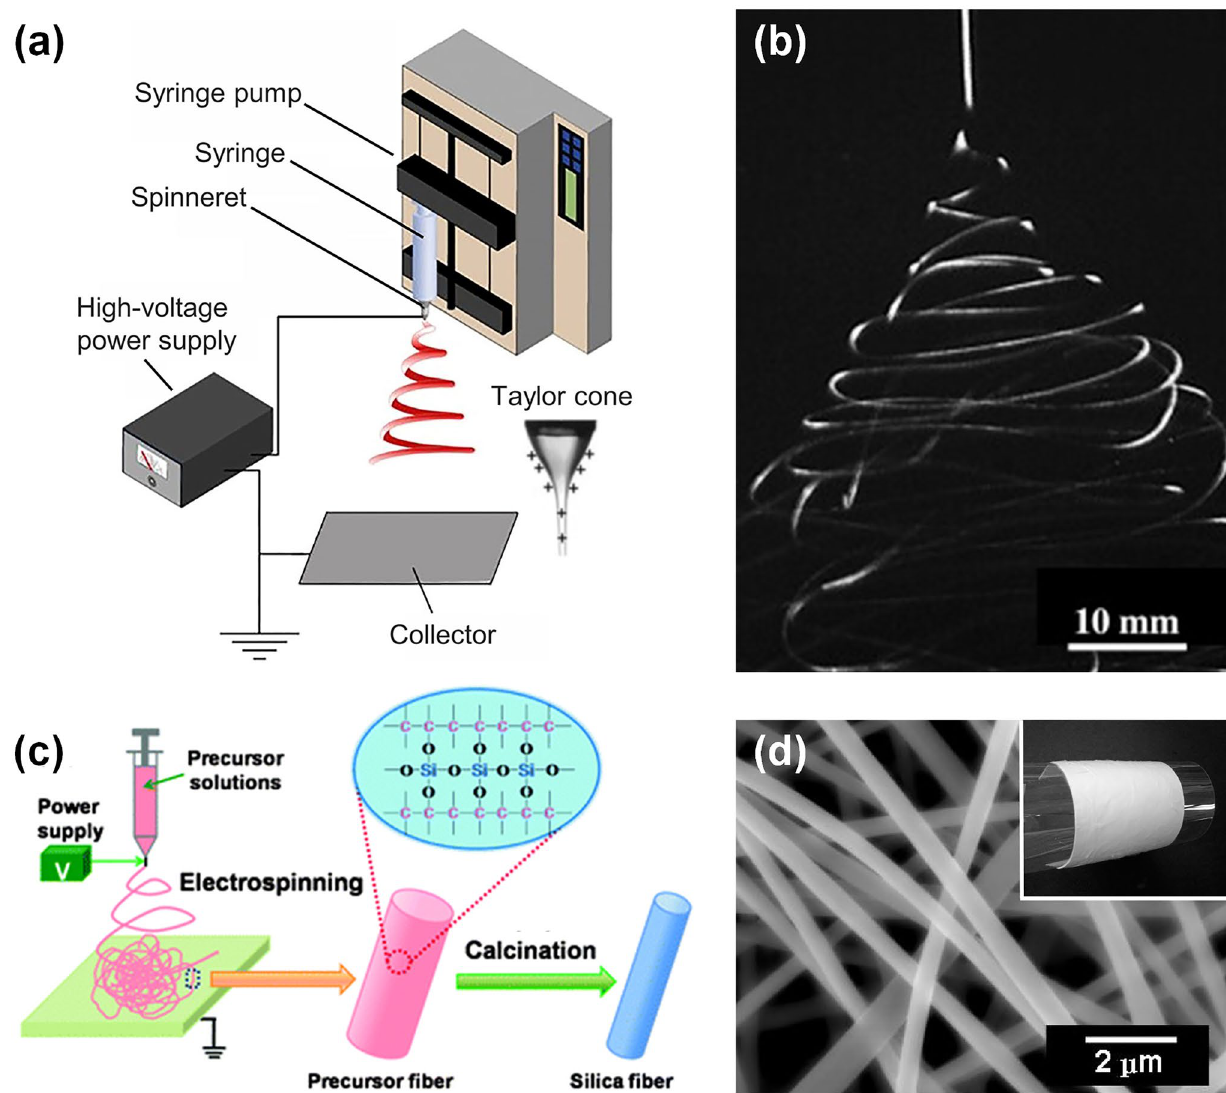
Fig. 2 a Schematic diagram of basic apparatus for electrospinning [64]. Copyright 2019, American Chemical Society. b Photograph of typical jet movement during electrospinning [68]. Copyright 2007, Elsevier. c Schematic representation of general process for preparing electrospun SNFs [71]. Copyright 2012, The Royal Society of Chemistry. d Scanning electron microscope (SEM) image of SNFs after calcination in air. The inset is the macroscopic flexibility exhibition of SNFs [74].Copyright 2010, American Chemical